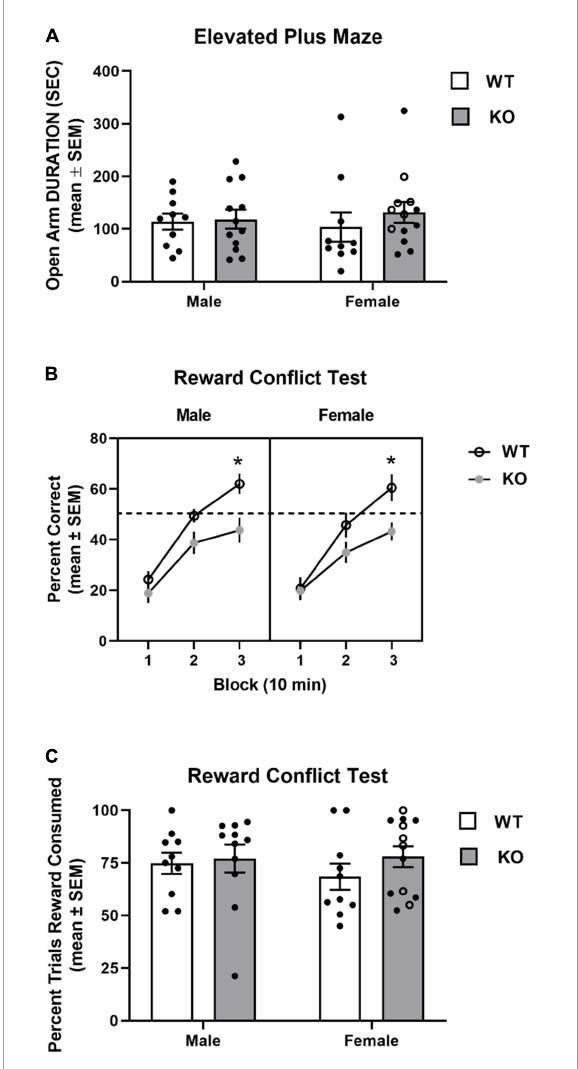
FIGURE8 Performance in elevated plus maze and reward conflict test. (A) Mean ( ± SEM) duration in the open arms in the elevated plus maze test. Wildtype (WT) and Fmr1 -knockout (KO) mice did not differ in open arm duration. (B) Mean ( ± SEM) percent correct across three 10 min blocks in reward conflict test. WT and Fmr1 -KO mice exhibited similar performance during the first block of testing with male and female WT mice exhibiting greater performance than Fmr1 -KO mice during the second and third blocks. * p < 0.05 vs. WT male and female mice. (C) Mean ( ± SEM) percent of open arm trials cereal reward was consumed. WT and Fmr1 -KO mice did not differ in percent of open arm trials cereal reward was consumed. In the female Fmr1- KO group, • , heterozygous mice and ◦ , homozygous